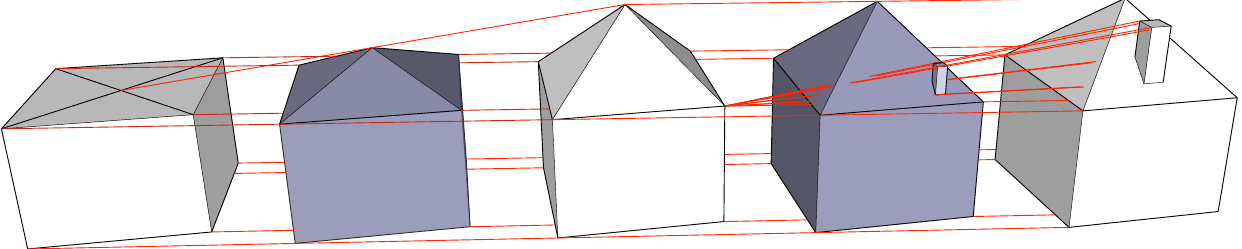
Figure 5. Three LODs of a 3D model of a house are integrated into a 4D model by modifying the topology of the model at the lowest LOD and collapsing a part of the model in the highest